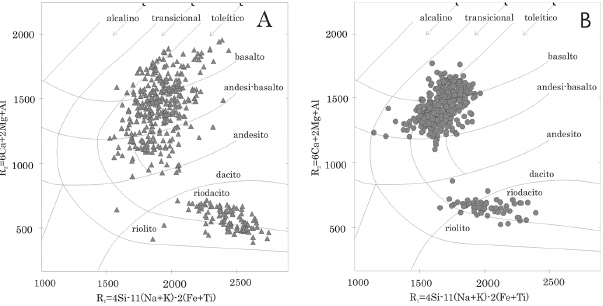
Fig. 2. R1 × R2 diagram (De La Roche et al., 1980). (A) Tholeiitic suite (Low-Ti basalts and ATP), and (B) tholeiitic-transitional suite (High-Ti basalts and